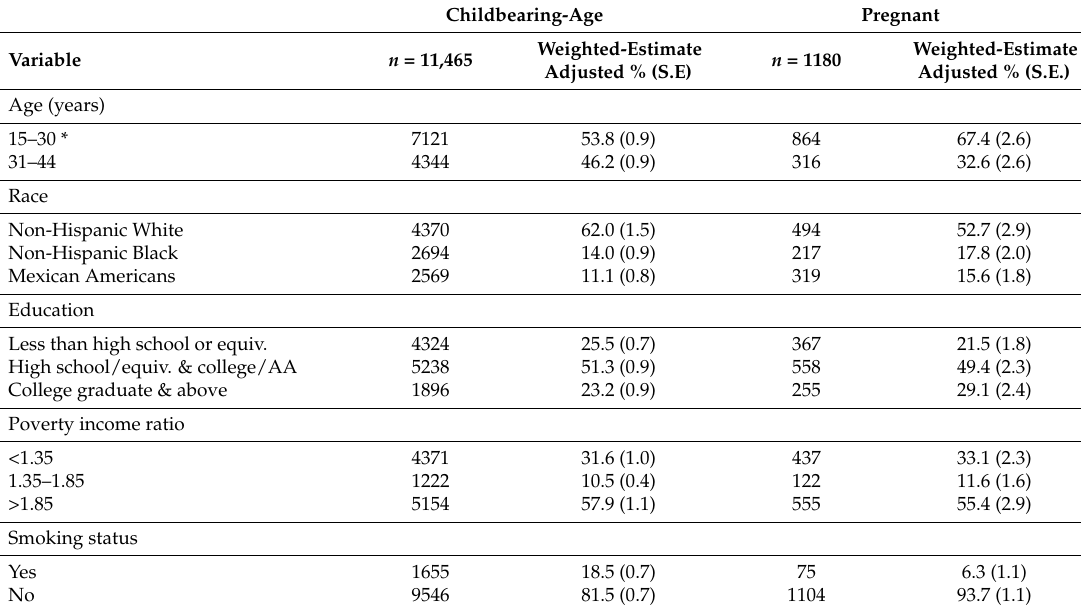
Table 3. Demographic characteristics of